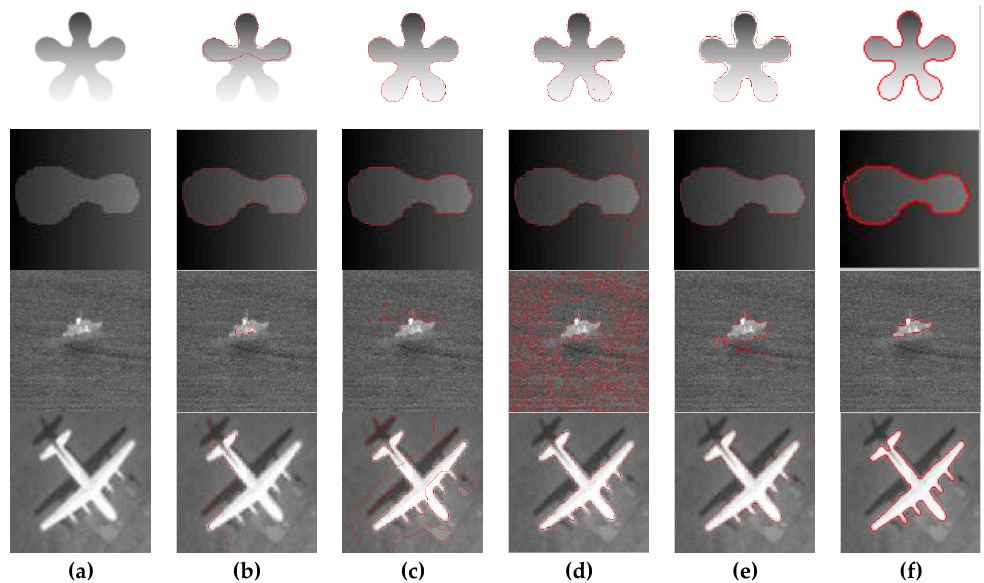
Figure 3. Comparisons of the five models in segmenting single-objective images: (a) The original image; (b) The segmentation results of the DRLSE model; (c) segmentation results of the LBF model; (d) The segmentation results of the LIF model; (e) The segmentation results of the LSACM model; (f) The segmentation results of the IRLS-IS model. DRLSE: distance regularized level set evolution; LBF: local binary fitting; LIF: local image fitting; LSACM: local image region statistics-based improved active contour model; IRLS-IS: improved regularized level set-based image segmentation.